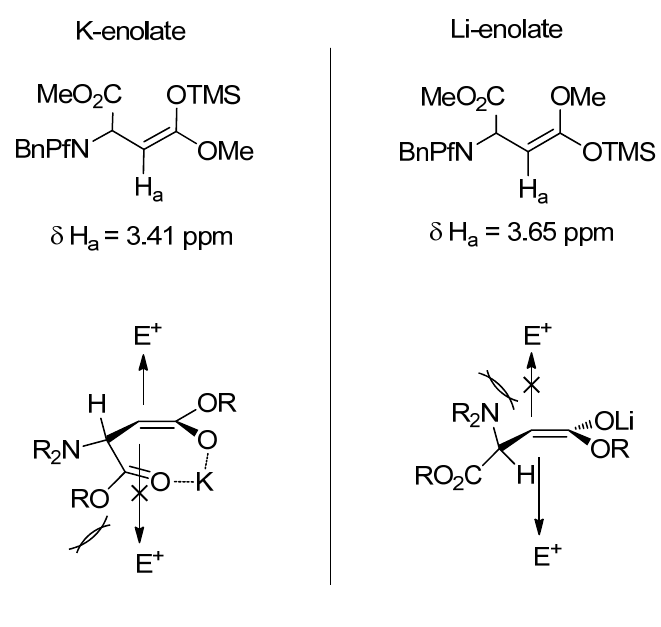
Figure 4. Silyl ketene acetals of potassium and lithium enolates, and the geometries that affect the stereoselectivity of